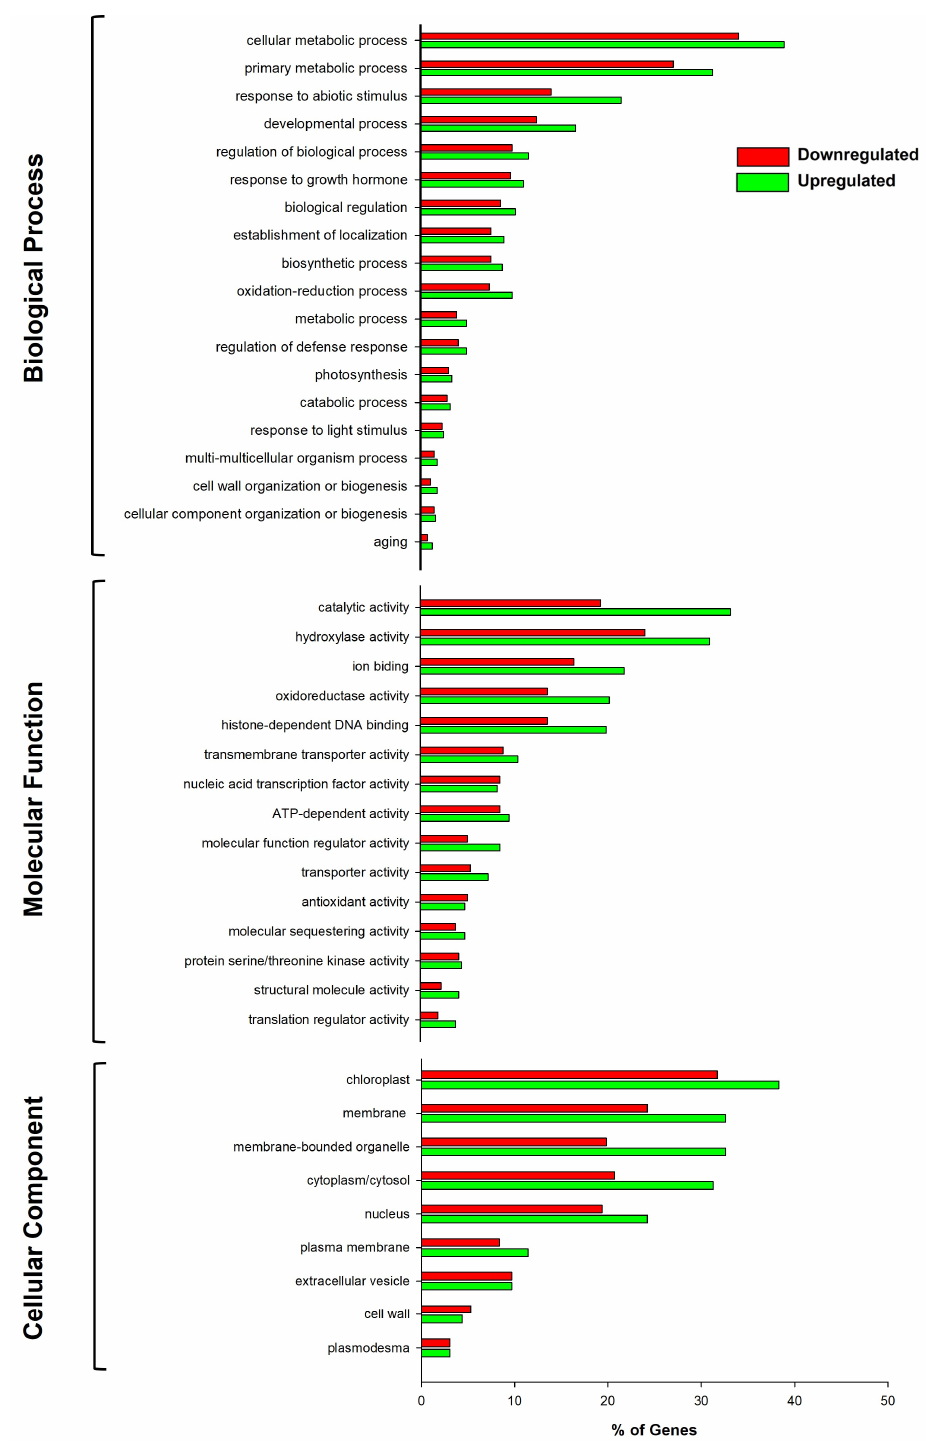
Figure 3. Gene ontology annotation analysis of DEGs in HLB-symptomatic Persian lime leaves. The percentage of genes is based on GO Slim terms for the three main categories of biological process, molecular function, and cellular component assigned to all genes.